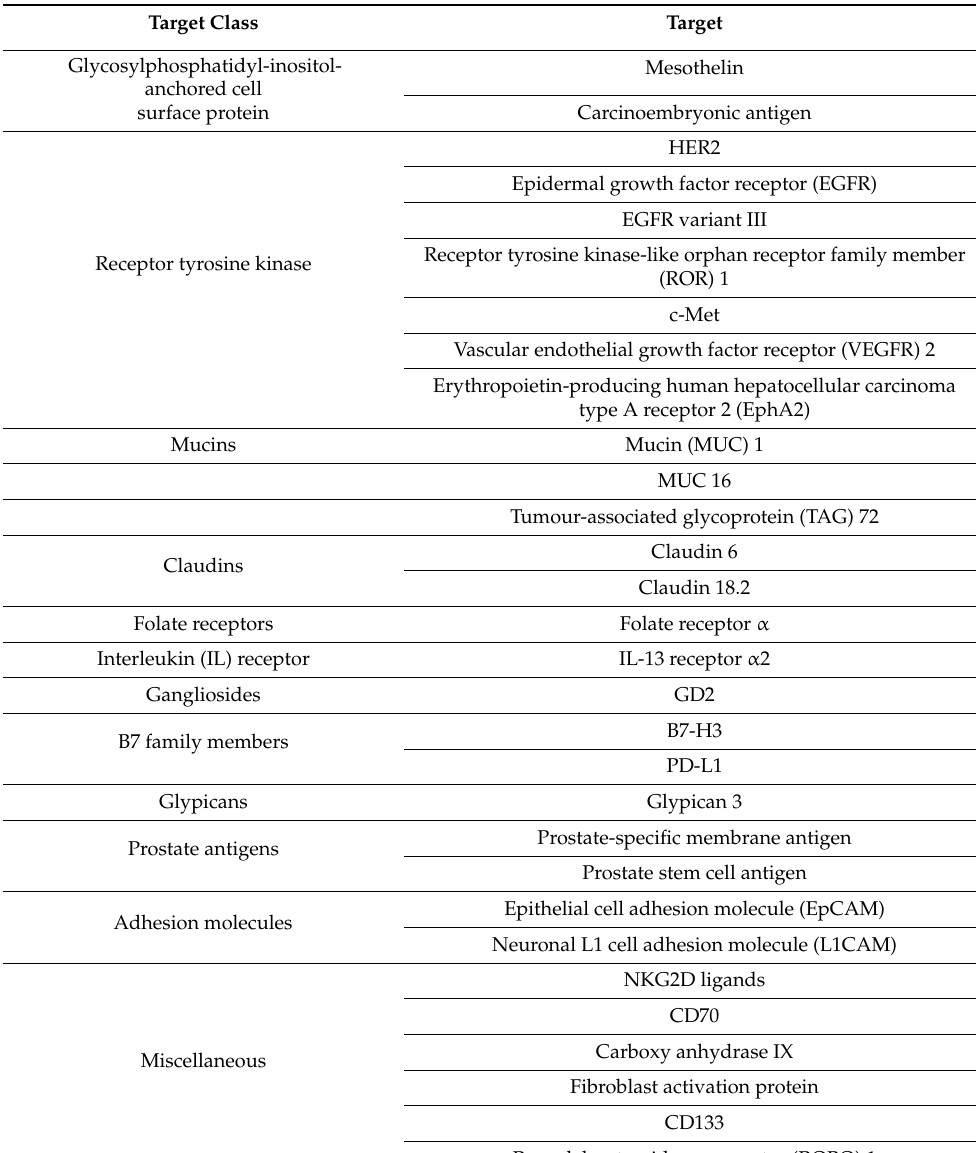
Table 1. Solid tumour CAR targets that have been evaluated